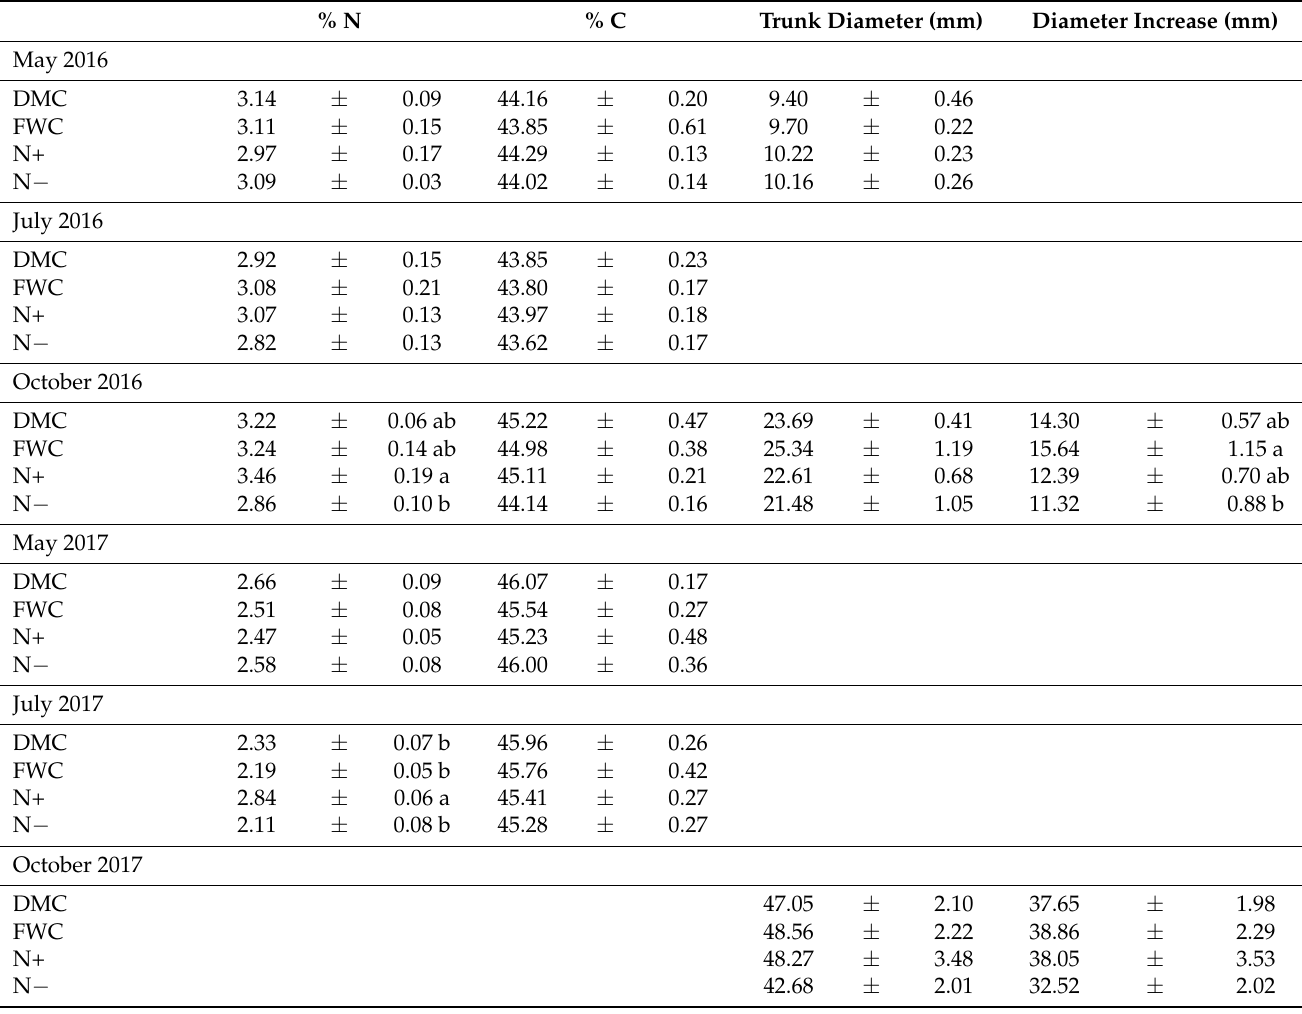
Table 5. Average leaf nutrients, trunk diameter and growth ± standard error of measurement (SEM) from an al- mond orchard receiving different organic amendments. Letters denote statistical differences of p < 0.05 determined by either post hoc Tukey’s honestly significant difference (HSD) test or Dunn’s test, for non-normally distributed